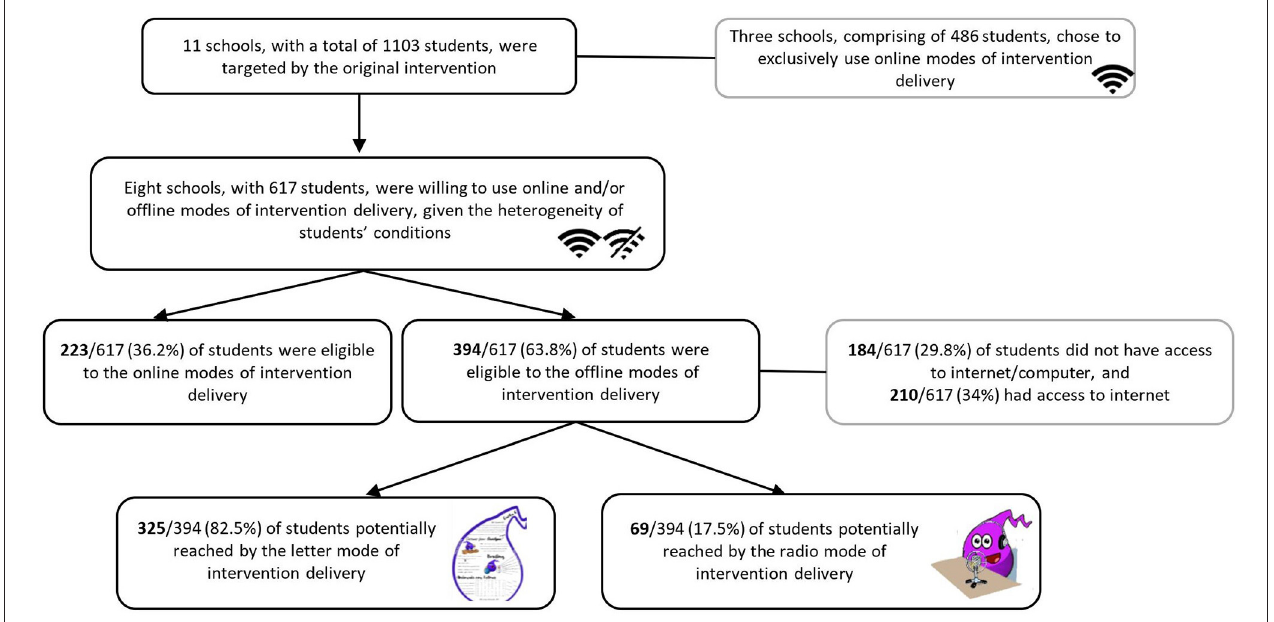
FIGURE 1 | Flow chart of the potential reach of the two offline modes intervention